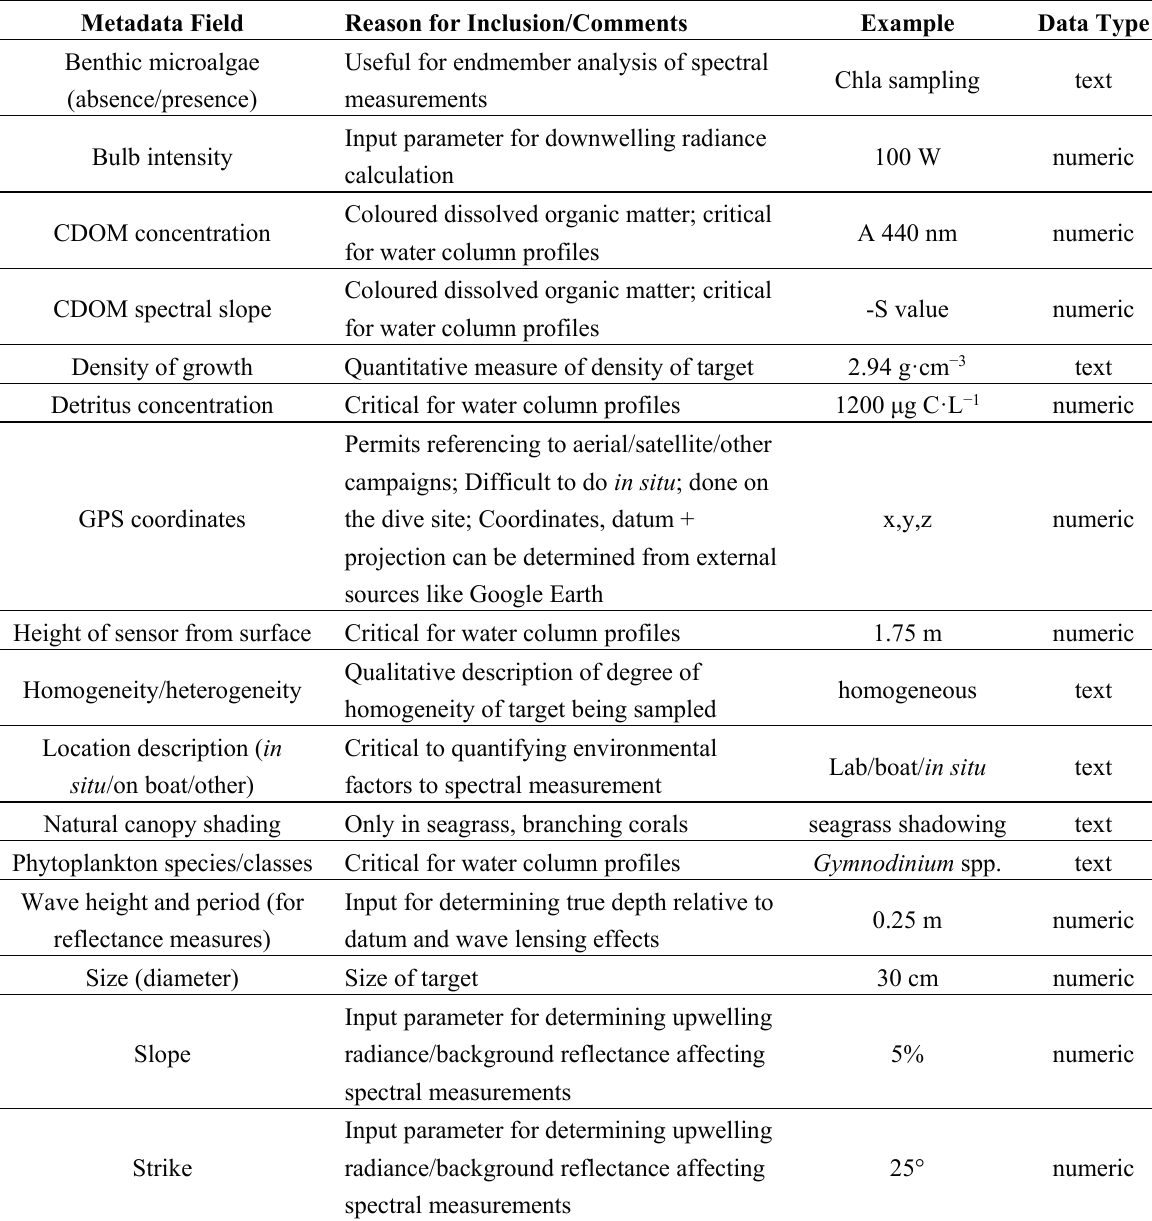
Table 5. Optional metadata for in situ benthic reflectance